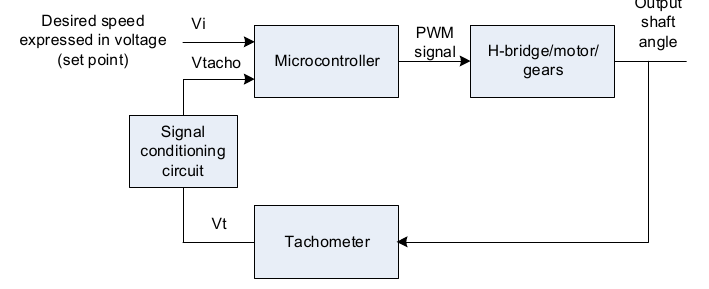
Fig. 2. Block diagram of the speed control